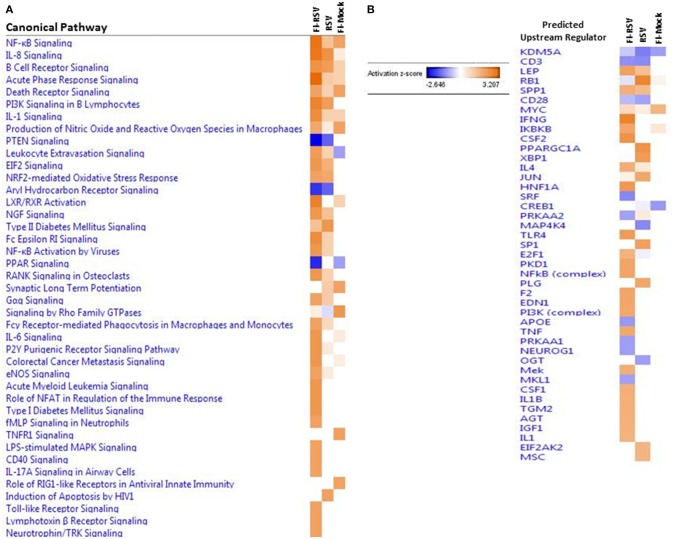
(A) Heat map of the comparative analysis of the canonical pathways significantly enriched in the indicated groups relative to PBS controls. (B) Heat map of the comparative analysis of the statistically significant upstream regulators predicted to be involved in the indicated groups. For both heat maps, only those with a Z-score equal to ± 2 are displayed. (n = 12).